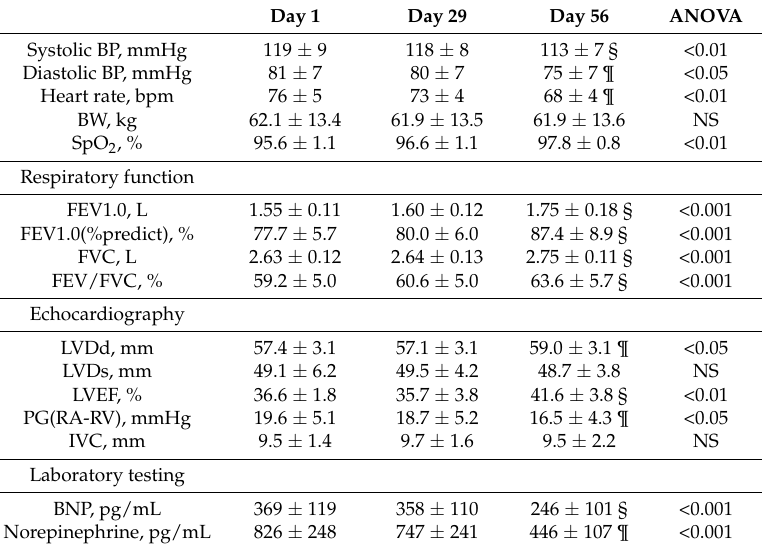
Table 3. Group B: observation + tiotropium.